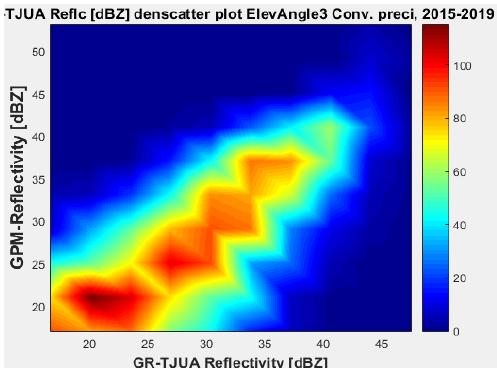
Figure 18. GPM ‐ Ku vs. NEXRAD TJUA for convective precipitation (angle 3).